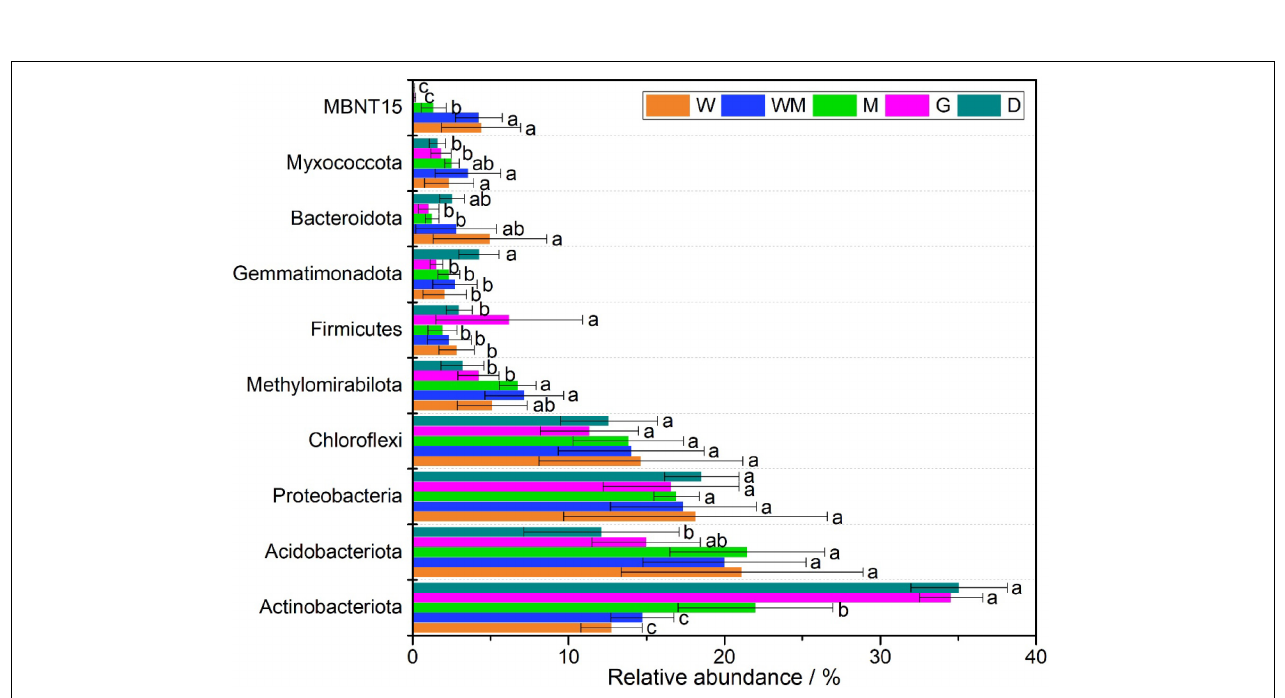
FIGURE 3 | Relative abundance of the top 10 phyla along alpine wetland degradation gradients. W, typical wetland; WM, wet meadow; M, meadow; G, grassland; D, desert. Different letters indicate significant difference at P < 0.05.